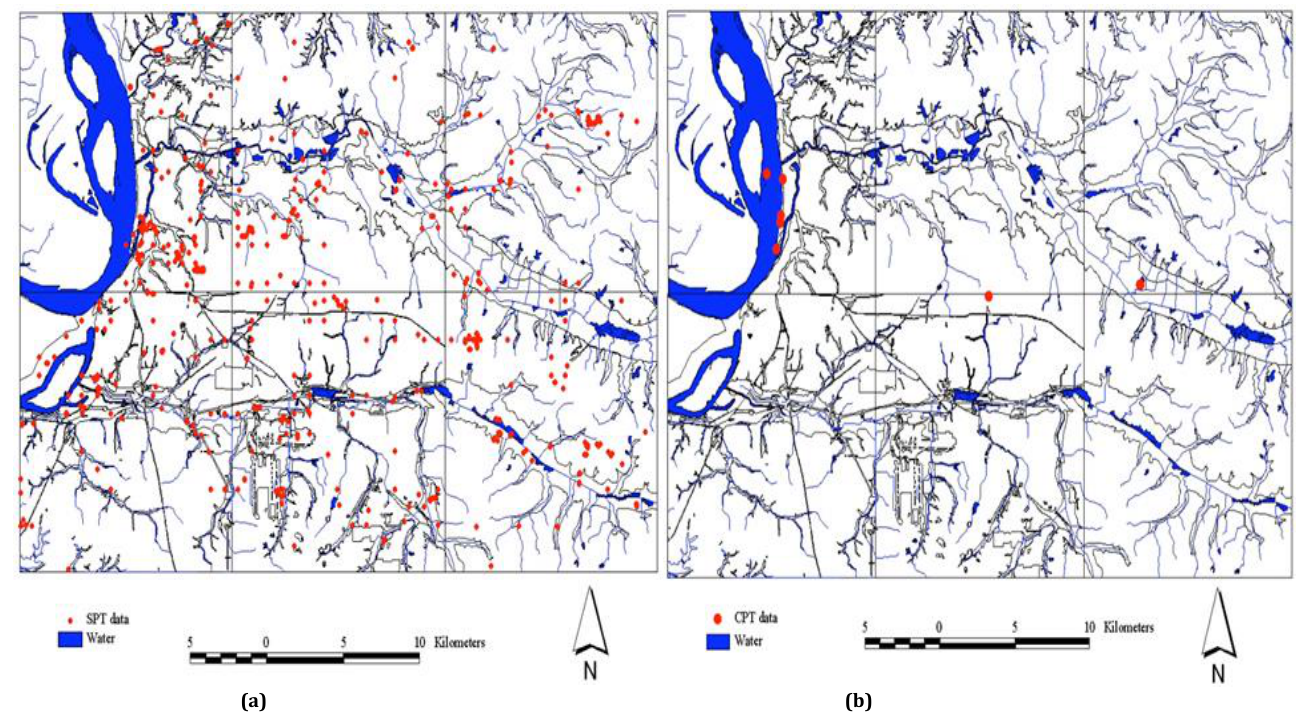
Figure 7: Location of (a) SPT and (b) CPT profiles on geological map after Rix and Hudock